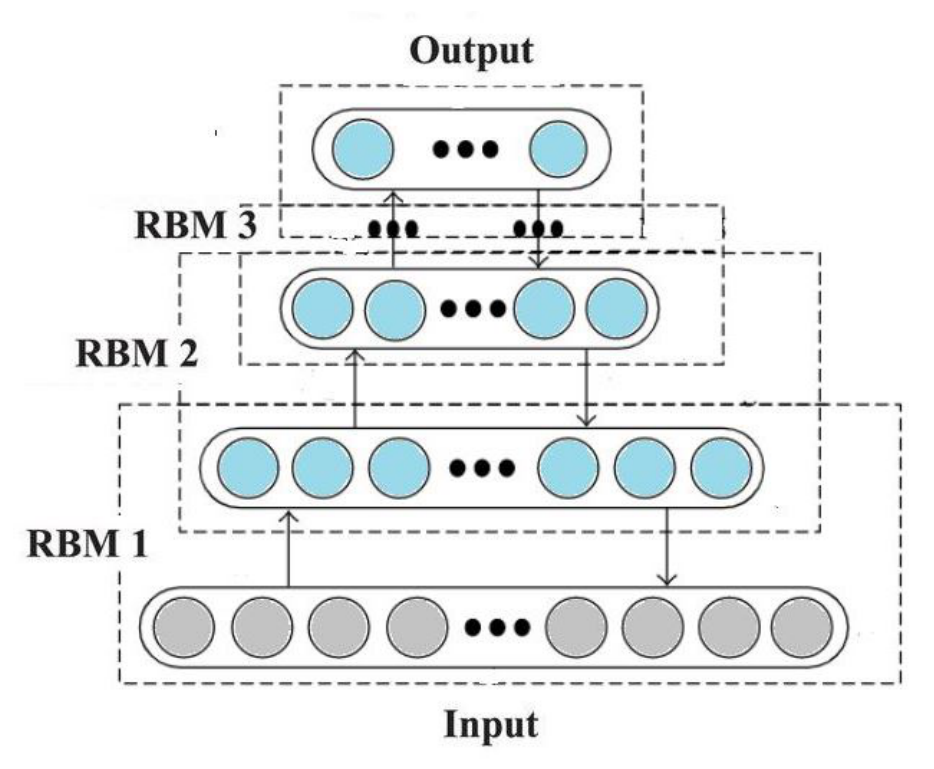
Figure 2. The DBN structure.